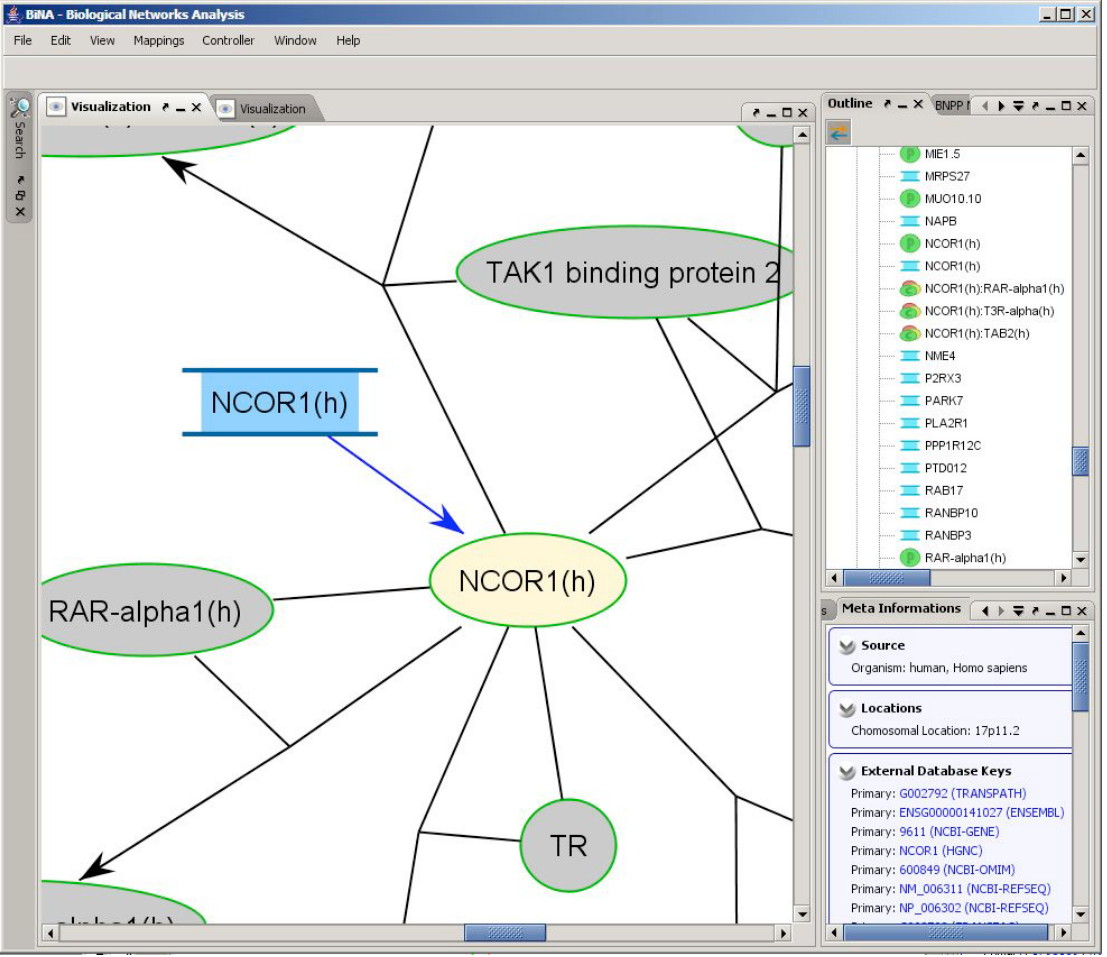
Figure 5: The human TGF-beta signaling pathway visualized with the regulatory view in BiNA. Each participant is shown as a node labeled with its name. The blue box represents a gene and the ovals proteins. The events are visualized with different types of edges: the black arrows represent different reactions, the blue arrow an